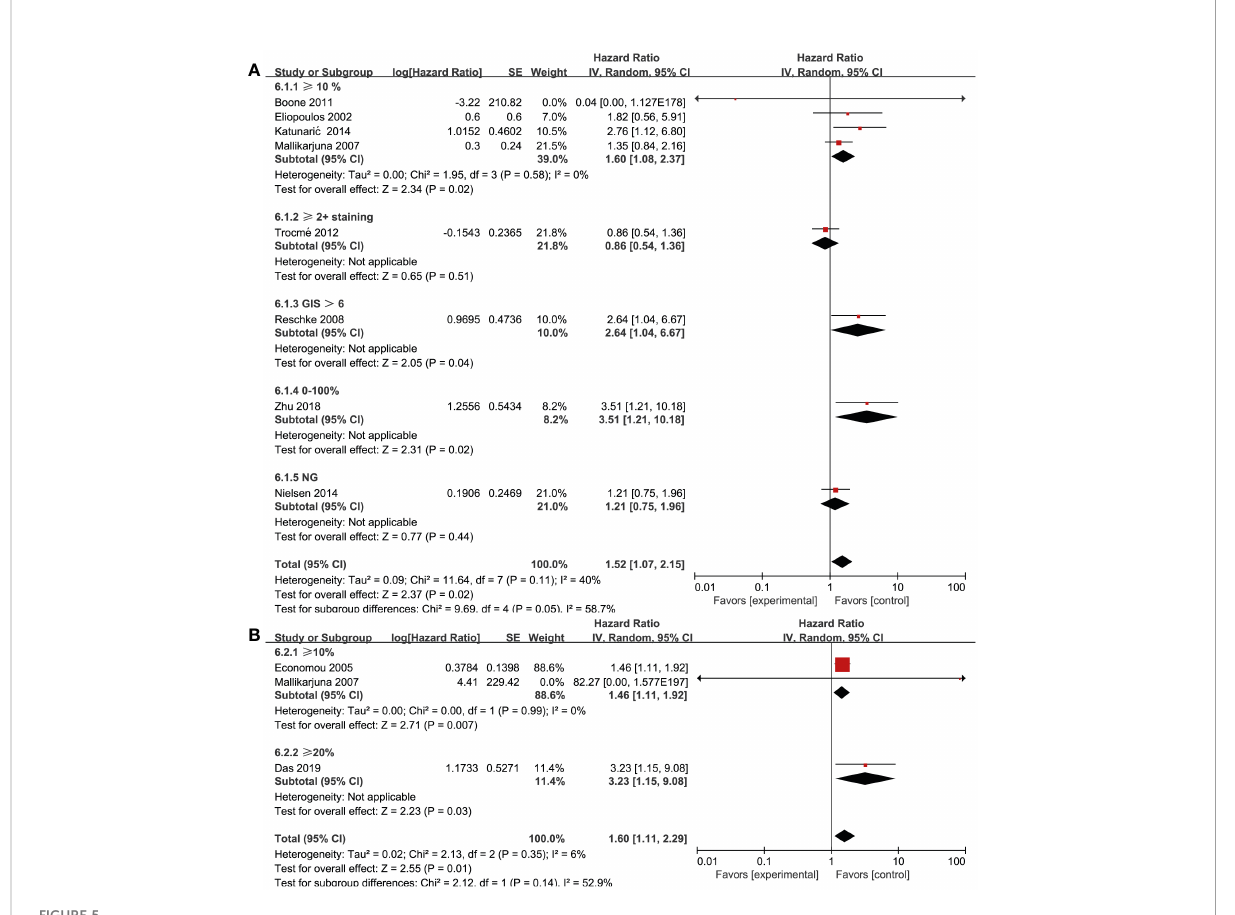
FIGURE 5 Association of various RTKs and cut-off. (A) EGFR, (B)